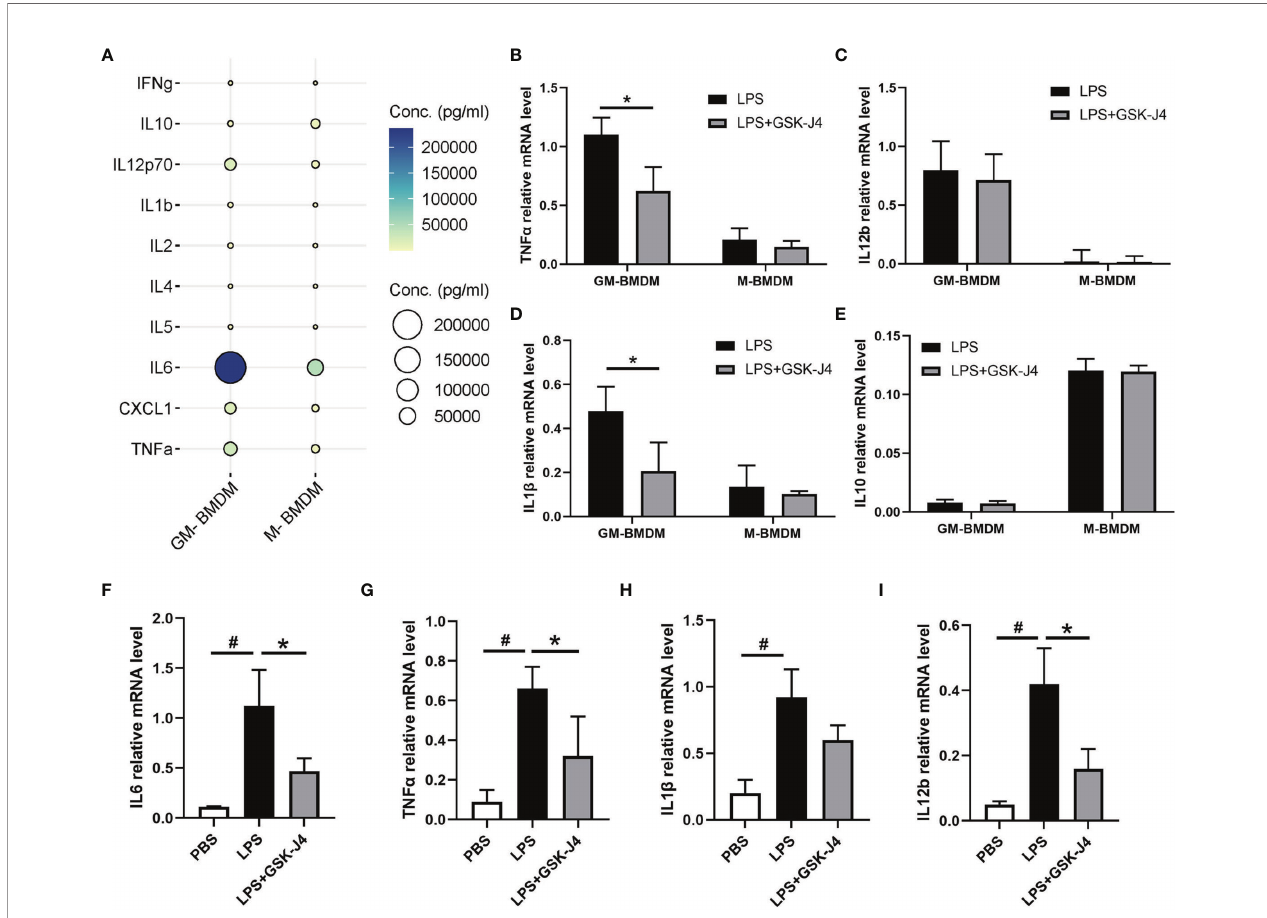
FIGURE 3 | GSK-J4 inhibits cytokine expression in macrophages. (A) The expression of cytokines in the culture media of BMDMs. (B – E) BMDMs were treated with GSK-J4 for 48 hours, the RNA levels of TNF a , IL12b, IL1 b and IL10 were determined by qRT-PCR. (F – I) THP-1 cells were fi rstly differentiated with PMA for 72 hours and followed by treatment with GSK-J4 for 48 hours, the RNA levels of IL6, TNF a , IL1 b and IL12b were measured by qRT-PCR. p < 0.05 (two-tailed Student ’ s T-test) is indicated by * for comparison with LPS+GSK-J4 vs. LPS, # for comparison with NC vs. LPS, error bars indicate